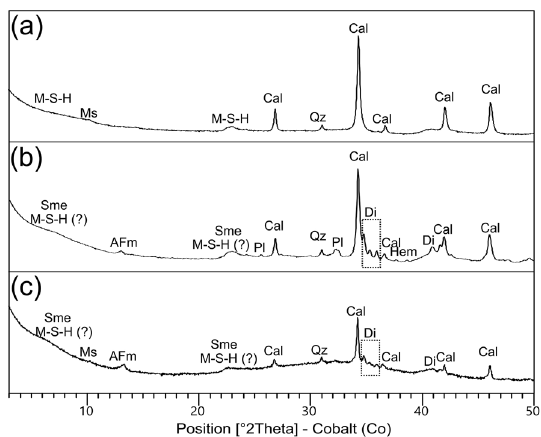
Figure 5. XRPD patterns of binder-concentrated fractions from representative samples of the three mortar groups, with indication of the main mineral phases (mineral abbreviation labelled according to 104 ). ( a ) sample PREF_12 (Group 1); ( b ) sample PREF_13B (Group 2); ( c ) sample PREP_25, lower layer (Group